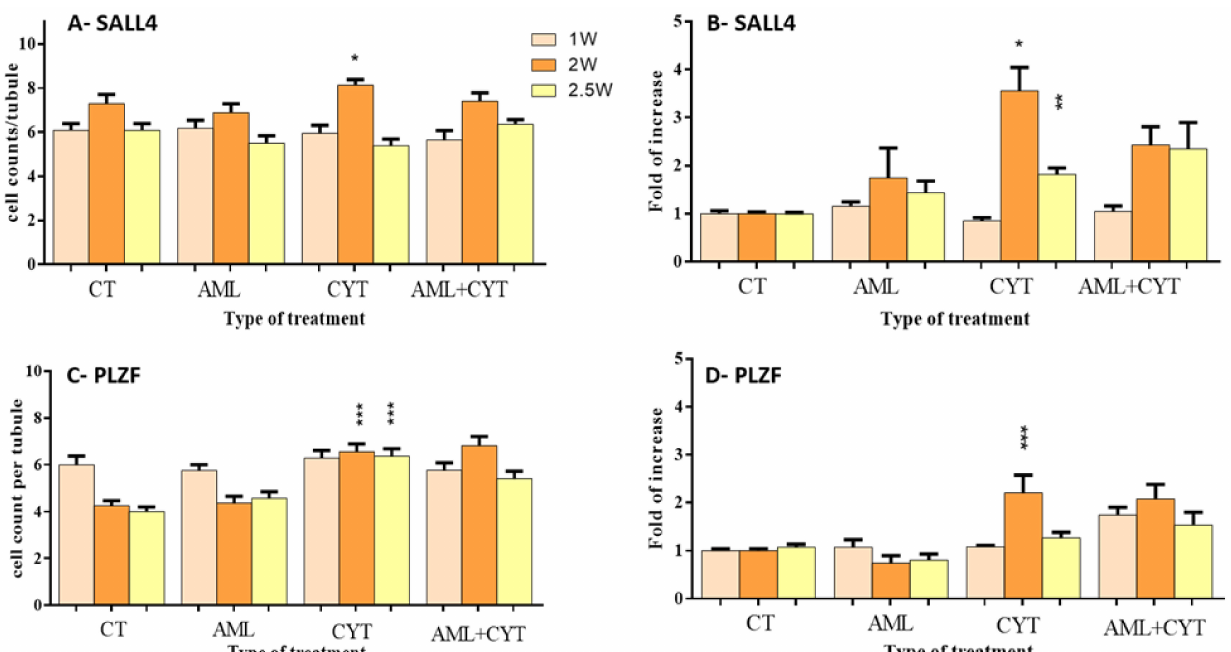
Figure 4. Effect of AML and CYT on the presence and expression levels of premeiotic markers. Mice were treated as described in Figure 1. Testes were removed after 1, 2 or 2.5 weeks and fixed or used for RNA extraction. Fixed testicular tissues were immunoassayed with specific anti-SALL4 and anti-PLZF antibodies to identify the premeiotic cells. SALL4-positive stained cells are presented as SALL4/tubule ( A ). The RNA expression levels of SALL4 in the testes isolated from each treatment group were examined by qPCR analysis using specific primers ( B ). PLZF-positive stained cells are presented as PLZF/tubule ( C ). The RNA expression levels of PLZF in the testes isolated from each treatment group were examined by qPCR analysis using specific primers ( D ), and housekeeping gene (GAPDH) was used as internal control. The results are presented as fold of increase compared to GAPDH (B). N = 3; n = 7–8/group; #tubules/group = 40–100; n = 5–7/group (RNA